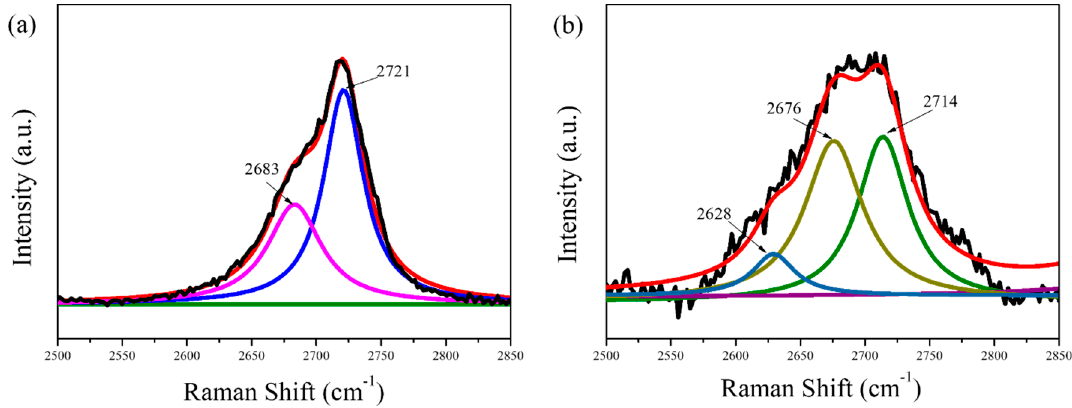
Figure 7. Enlarged images with fitting curves of 2D-band of pristine graphite ( a ) and the as-prepared graphene film ( b ).